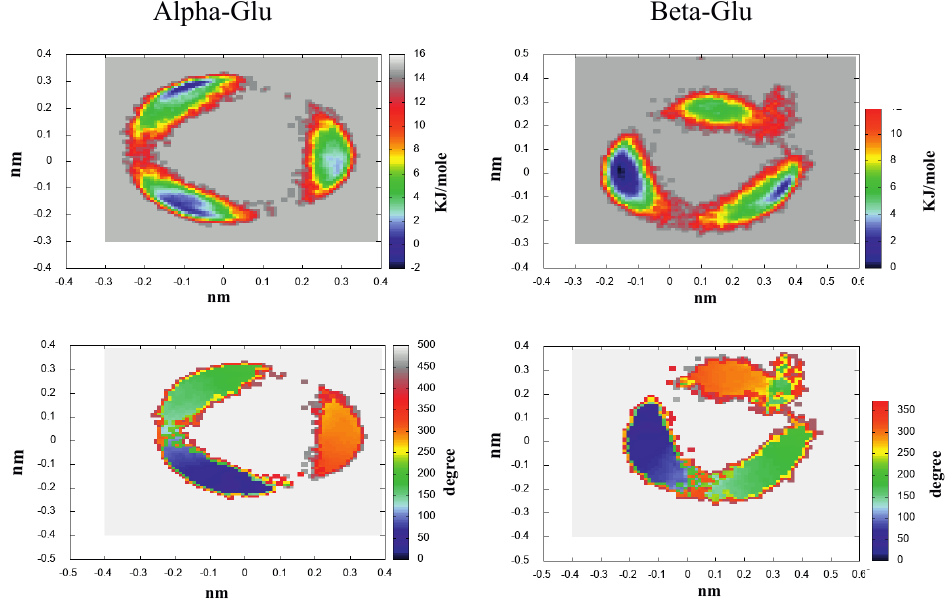
Figure 4. 300 K Helmholtz free-energy variation in the essential plane for Alpha-Glu (left-upper panel) and Beta-Glu ( right-upper panel). The O6-C-C-O5 torsion angle (mean) value as a function of the essential plane position for Alpha-Glu ( left-lower panel) and Beta-Glu ( right-lower